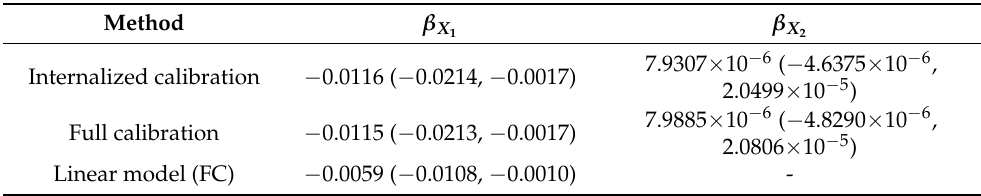
Table 5. Point estimates and 95% confidence intervals for the nonlinear (and linear) association of circulating 25(OH)D (nmol/L) with colorectal cancer after adjusting for BMI (overweight or not), physical activity (continuous), smoking (never/ever), and family history of colorectal cancer (yes/no).